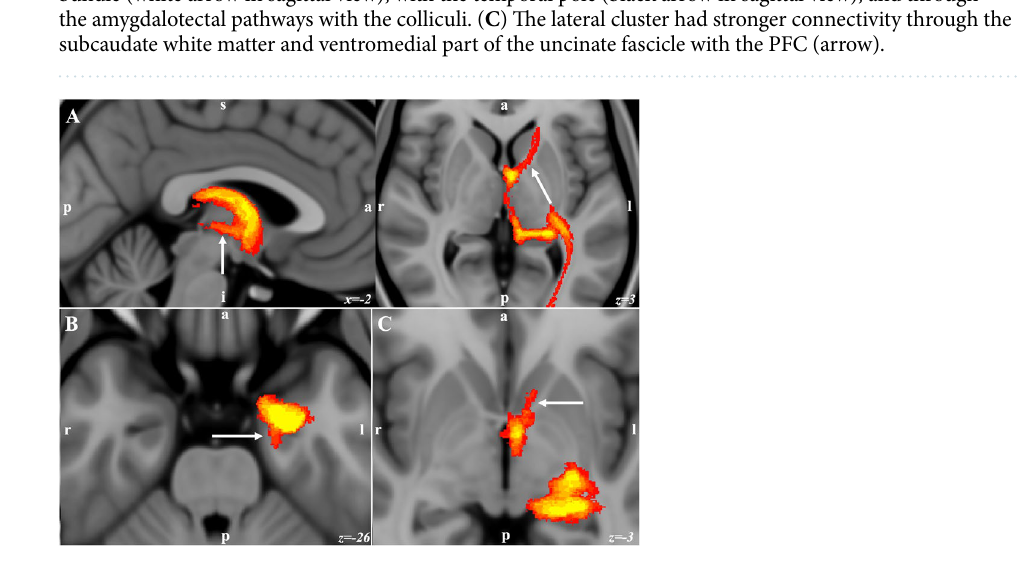
Figure 6. Population connectivity maps of the amygdala clusters. ( A ) The basal cluster had stronger connectivity with the medial thalamus through the inferior thalamic peduncle (arrow in sagittal), and through the anterior limb of the internal capsule with the PFC (arrow in axial view). ( B ) with the HC through the amygdalohippocampal bundle and (arrow). ( C ) with the ventral striatum (arrow in C